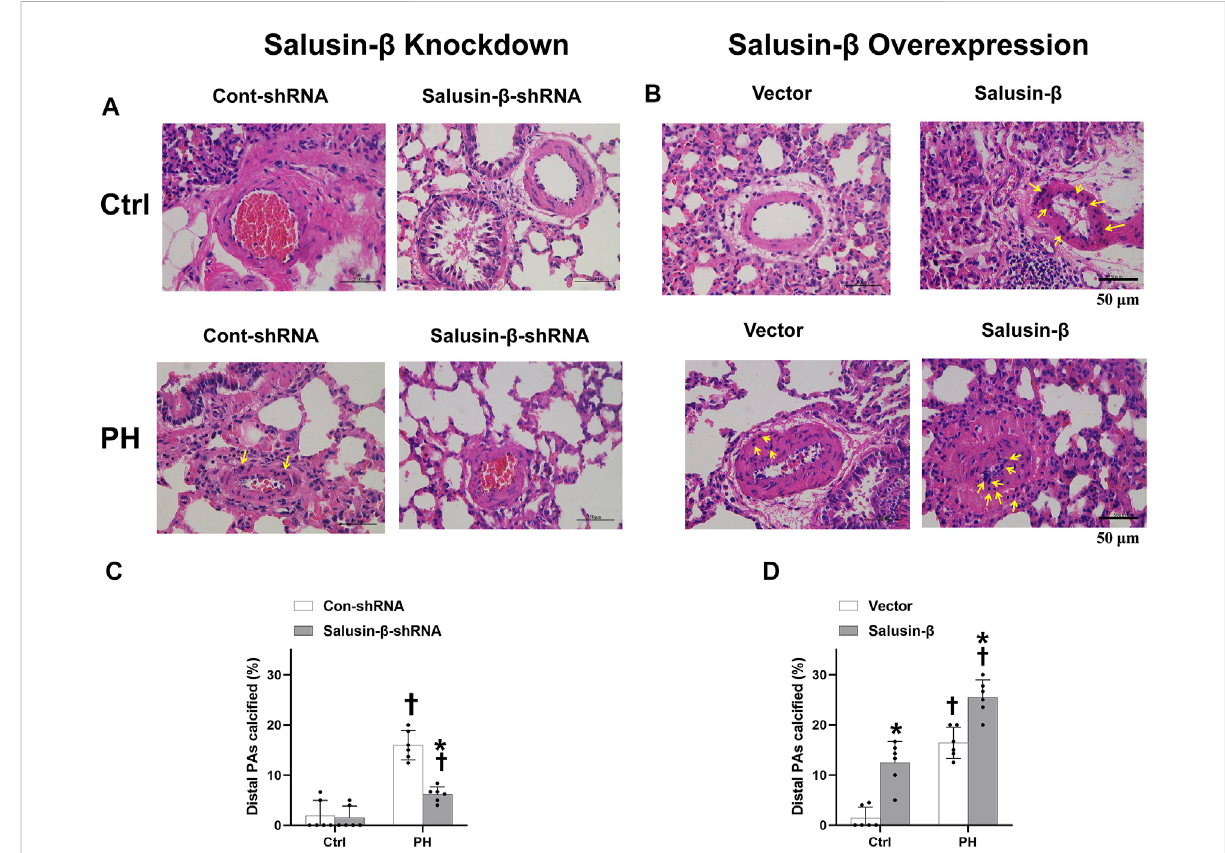
FIGURE 4 Representative images of lung tissue cross-sections with Von Kossa staining (The calcium deposits are black spots, with blue nuclei and a red background),inwhichtherepresentativecalciumdepositswereindicatedbyyellowarrows (A) andstatisticalpercentageofcalci fi edPAs (C) showing the effects of salusin- β knockdown on vascular calci fi cation in PAs; images of lung tissue cross-sections with Von Kossa staining (B) and percentage of calci fi ed PAs (D) showing the effects of salusin- β overexpression on vascular calci fi cation in PAs. Values are mean ± SE. * p < 0.05 compared with Con-shRNA or vector. † p < 0.05 compared with control (Ctrl) rats. n = 6 for each